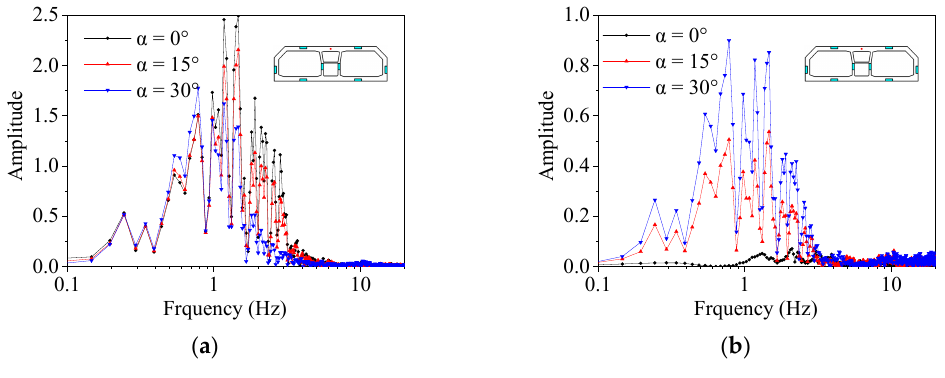
Figure 13. Fourier spectrum of roof midpoint: ( a ) horizontal; ( b ) vertical.